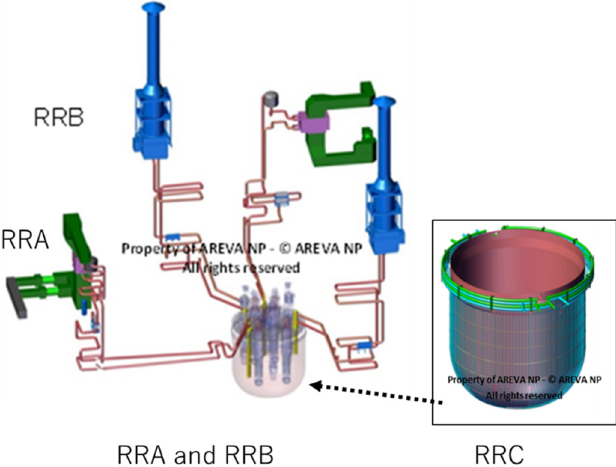
Fig. 6. DHRS in ASTRID